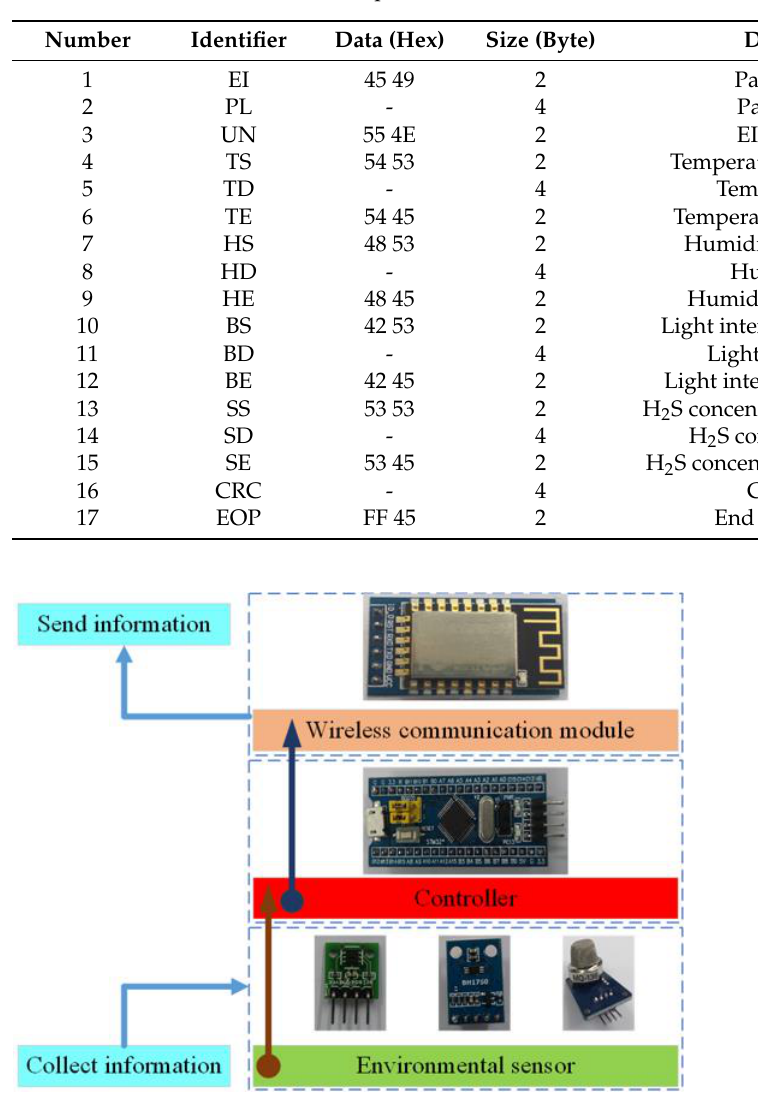
Table 4. Environmental information packet format.